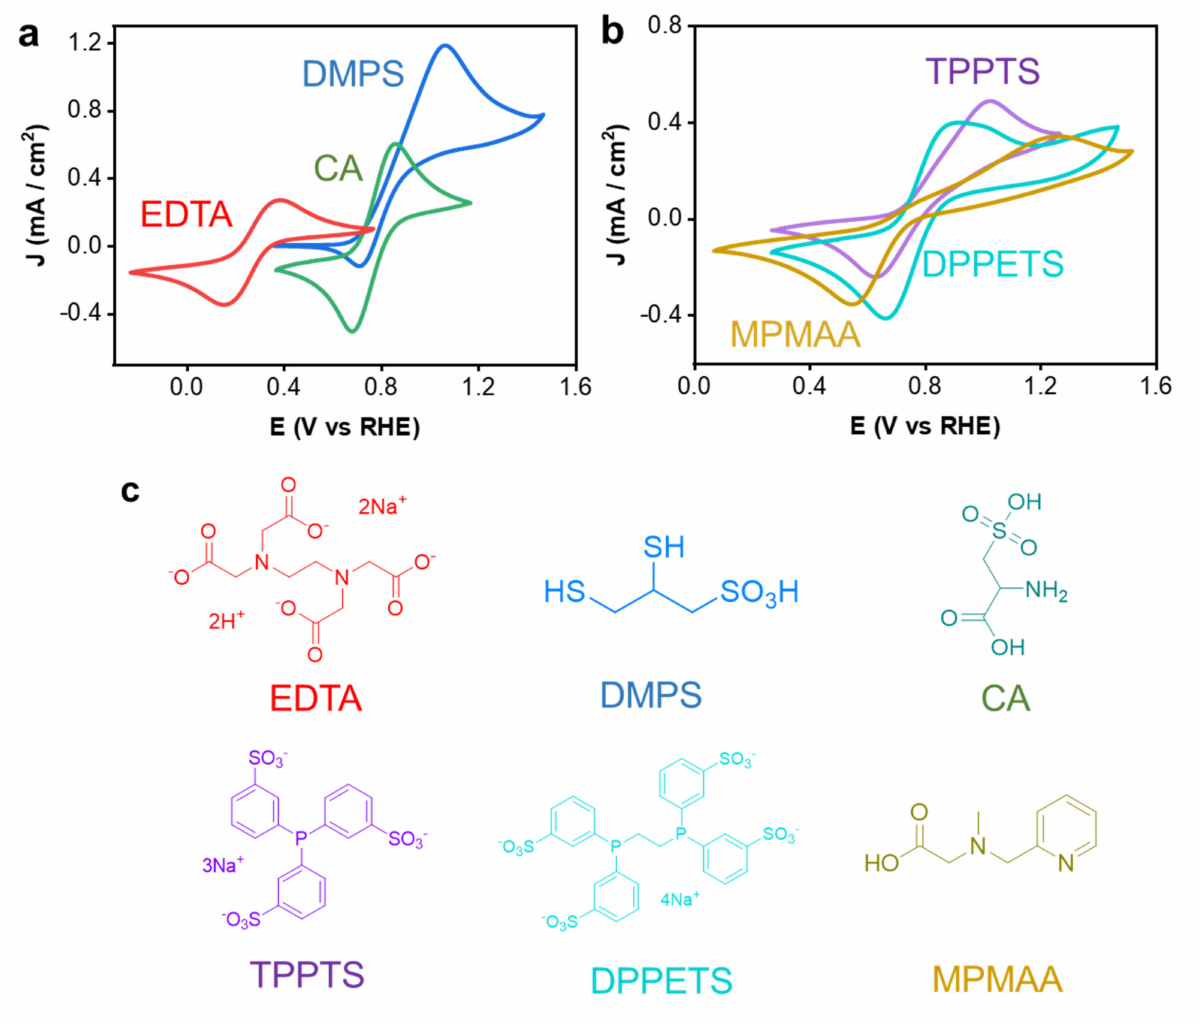
Figure 2. CV curves of 10 mM Fe-complex examined with glassy carbon plate in a 0.1 M Na 2 SO 4 aqueous solution with a scan rate of 10 mV s − 1 . ( a ) Fe 2+ -EDTA, Fe 2+ -(DMPS) 2 , Fe 2+ -(CA) 2 , and ( b ) Fe 2+ MPMAA, Fe 2+ -(TPPTS) 2 , and Fe 2+ -(DPPETS) 2 . ( c ) Molecule structure of ligand